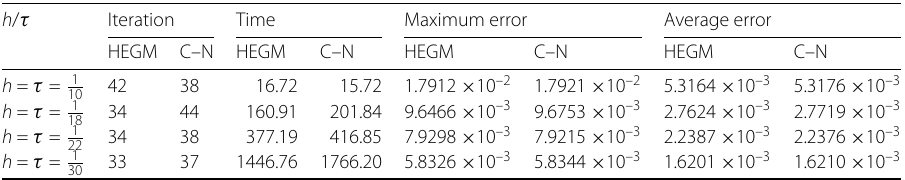
Table 3 Comparison between Crank–Nicolson (C–N) method and HEGM for Example 2 when γ = 0.5